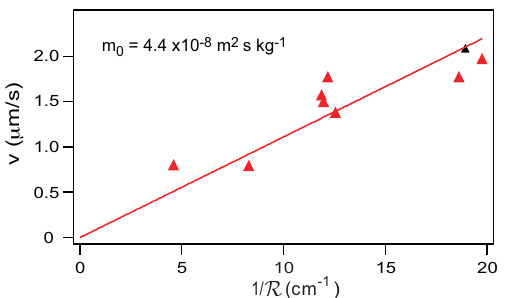
Figure 10. Dislocation velocity v measured in the asymptotic regime as a function of the curvature of the meniscus 1/ R (Reprinted with permission from Phys. Rev. E, 62, 3747 (2000). Copyright 2000, American Physical Society).